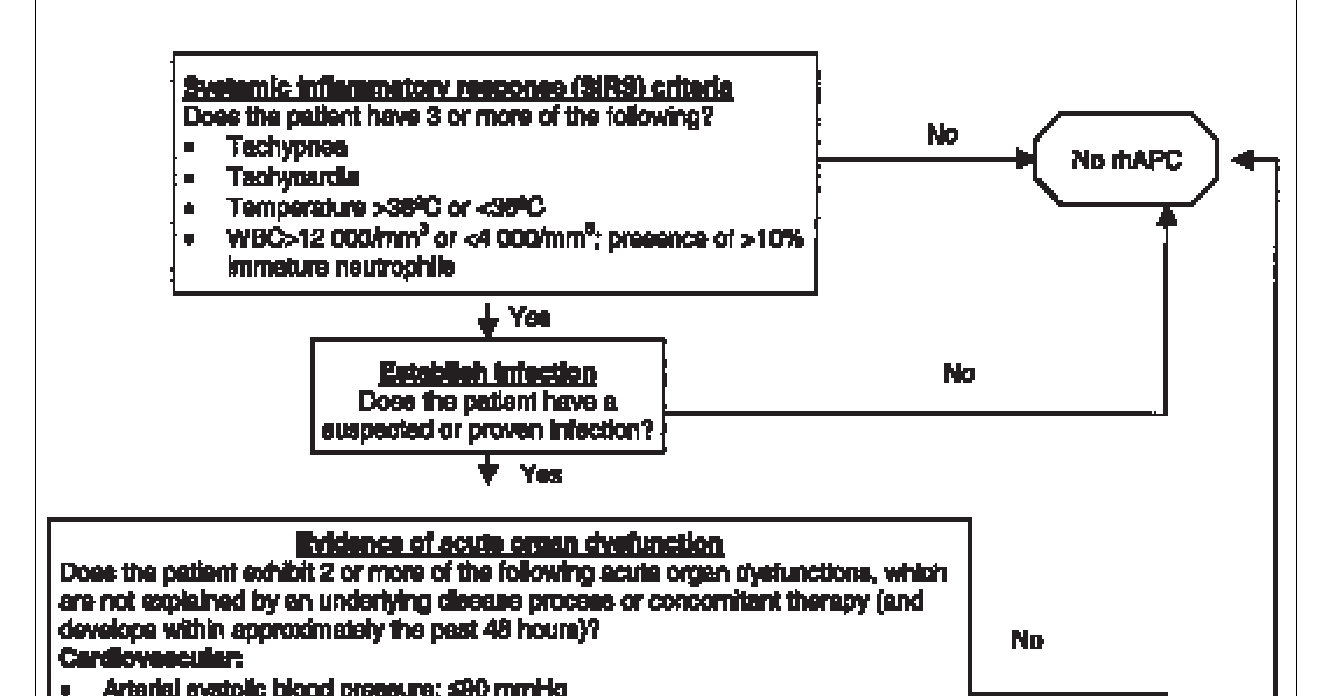
Fraction of inspired 2